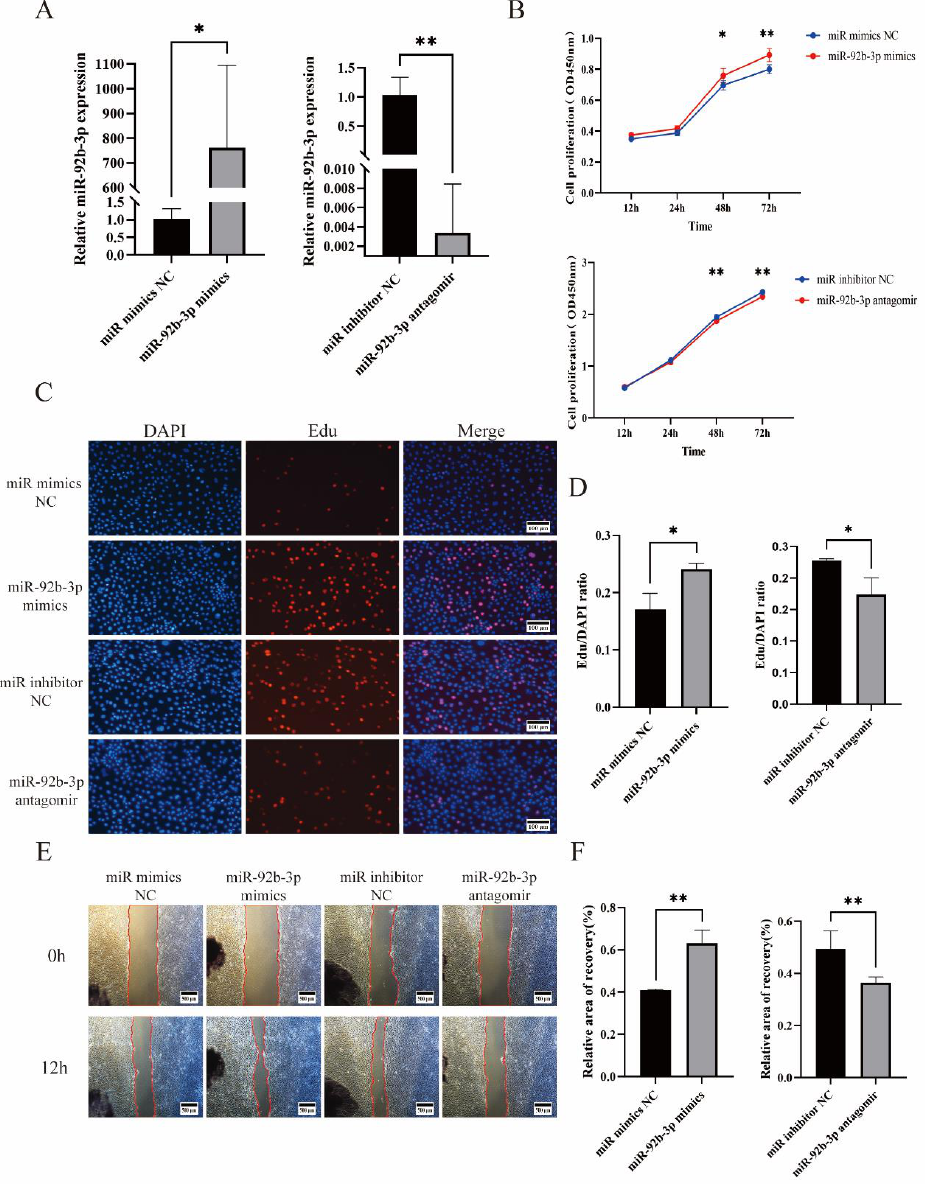
Figure 2. Effect of miR-92b-3 on PTr2 proliferation and migration. ( A ) Transfection of miR-92b-3p mimics into PTr2 induced a significant upregulation of miR-92b-3p expression; transfection of miR-92b-3p inhibitors induced an opposite effect. ( B – D ) CCK-8 and Edu results demonstrated that miR-92b-3p overexpression promoted PTr2 proliferation, and inhibition of miR-92b-3p expression inhibited PTr2 proliferation. ( E , F ) Elevated miR-92b-3p promoted PTr2 migration; reduced miR-92b-3p inhibited PTr2 migration. Data are expressed as the means ± SEM of three experiments. (* p < 0.05; ** p < 0.01).